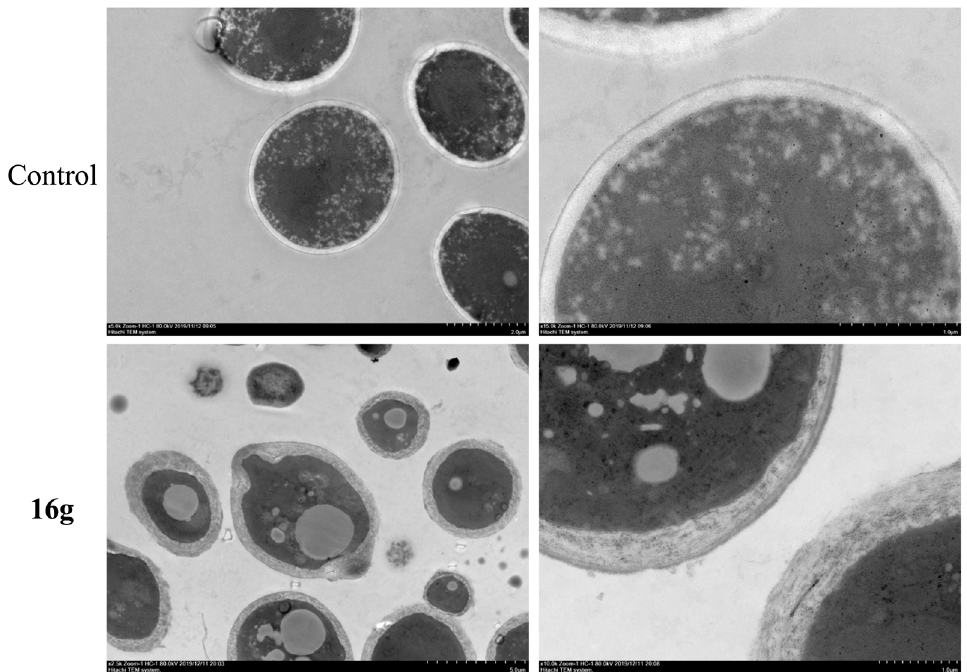
Figure 6. Cell wall damage caused by compound 16g in C. albicans . C. albicans SC5314 was treated with 1 μ g/mL of 16g for 16 h. The structural changes of cell wall were observed by transmission electron microscope. con: control.